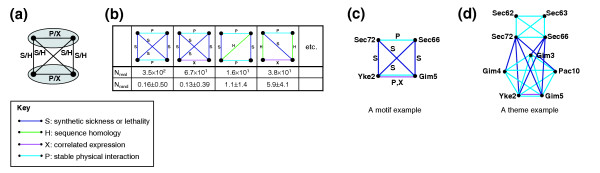
Four-node network motifs corresponding to the 'compensatory complexes/processes' theme. (a) A schematic diagram unifying the collection of four-node motifs corresponding to the 'compensatory complexes/processes' theme; (b) examples of specific four-node motifs together with the motif statistics; (c) a specific example of a four-node subgraph matching a few of these motifs; (d) the larger structure corresponding to the network theme. Each colored link represents one of the four interaction types according to the color scheme (see key). For a given motif, Nreal is the number of corresponding subgraphs in the real network, and Nrand describes the number of corresponding subgraphs in a randomized network, represented by the average and the standard deviation.